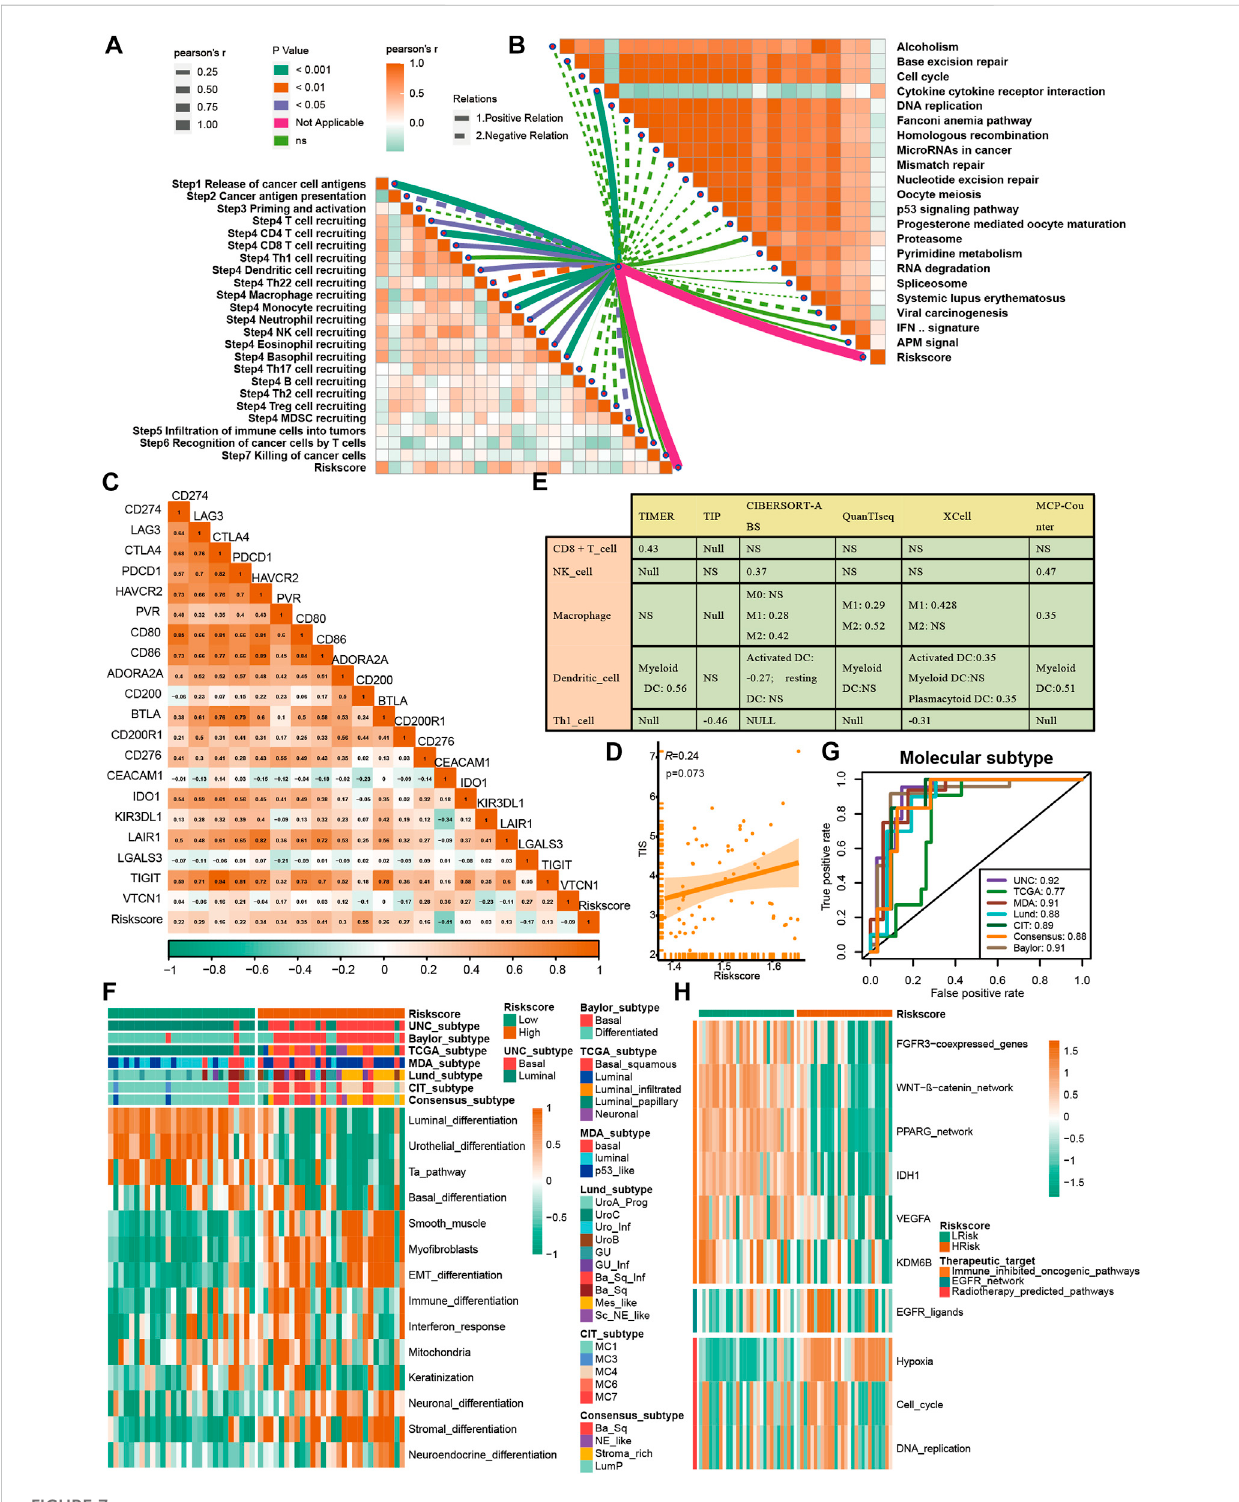
FIGURE 7 Validation of VM_Score in Xiangya cohort. (A) Relationship between VM_Score and activities of cancer immunity cycles. (B) Relationship between VM_Score and immunotherapy predicted pathways. (C) Correlations between VM_Score and several immune checkpoints. (D) Relationship between VM_Score and T cell in fl ammation score (TIS). (E) Relationship between VM_Score and in fi ltration levels of fi ve tumor- in fi ltrating immune cells. (F) VM_Score accurately strati fi ed the molecular subtypes in seven different algorithms. (G) Accuracy of VM_Score in predicting molecular subtypes in seven different algorithms. (H) Relationship between VM_Score and enrichment scores of several therapeutic